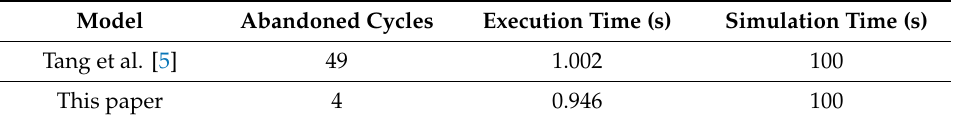
Table 6. Comparison of simulation